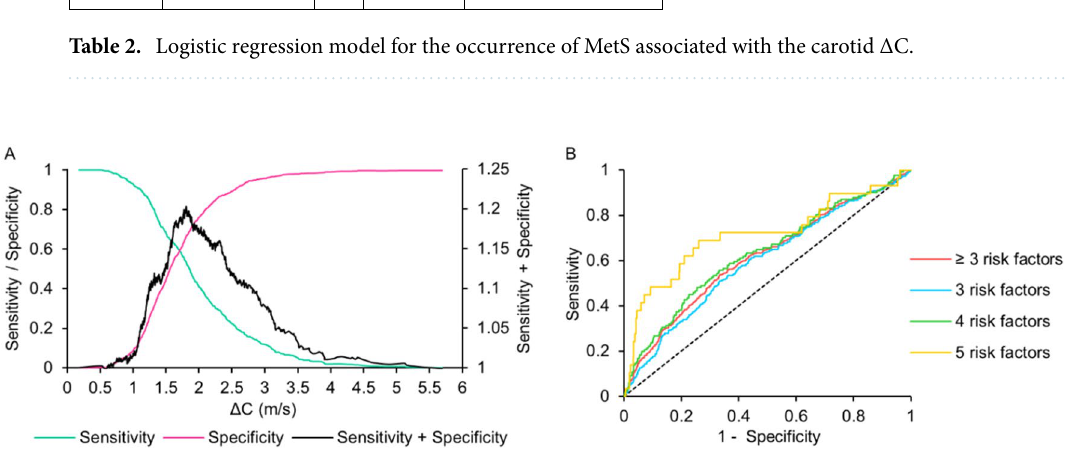
Figure 4. ( A ) Incremental pulse wave velocity, ΔC, versus sensitivity and specificity for the occurrence of ≥ 3 risk factors, ( B ) Receiver Operating Characteristic (ROC) curves for prediction of MetS with 3, 4, 5 or ≥ 3 risk